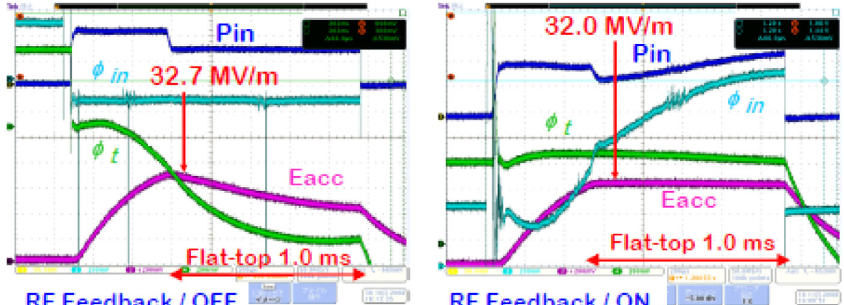
18. (Color) Pulsed signals at high field operation in C/#2 cavity without an rf feedback control (left) and with rf feedback control ) between the input rf power and a reference. The green line is the cavity phase ( (cid:2) t ) (right). The light blue line is the input phase ( (cid:2) in between the rf power transmitted through a cavity and a reference. The dark blue line is the input rf power, and the purple line is the accelerating